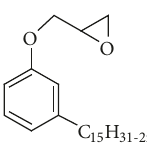
Figure 1: The molecule structure of